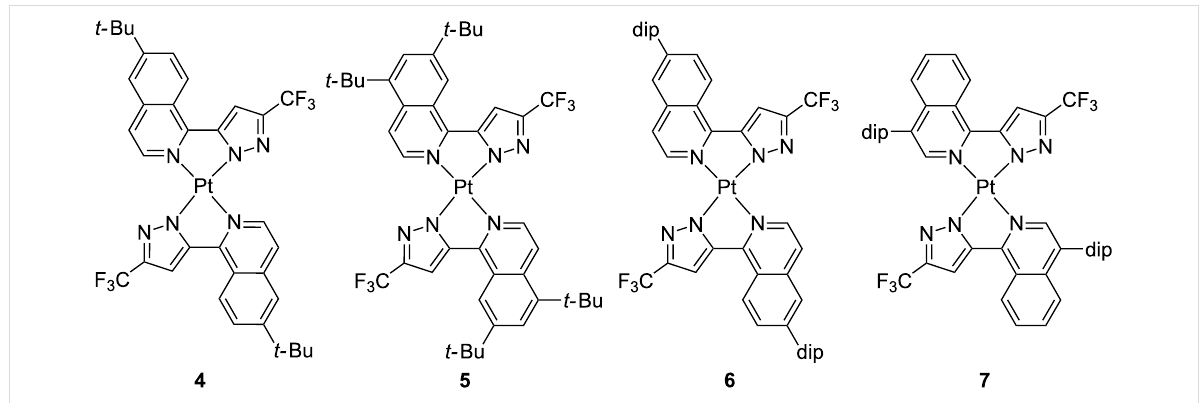
Figure 3: Molecular structure of platinum(II) complexes bearing isoquinolinylpyrazolates; dip = 2,6-diisopropylphenyl [26].